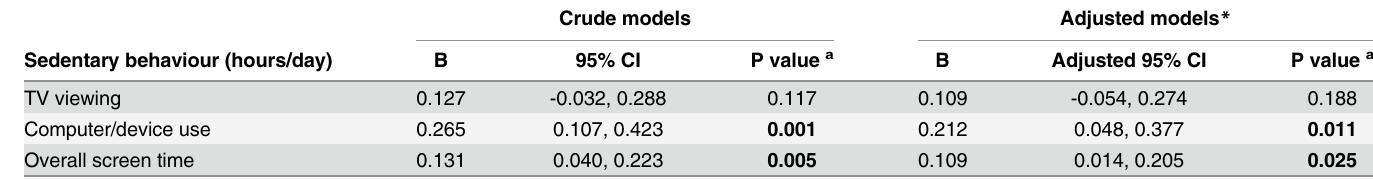
Table 2. Linear regression analyses examining associations between sedentary behaviours and anxiety